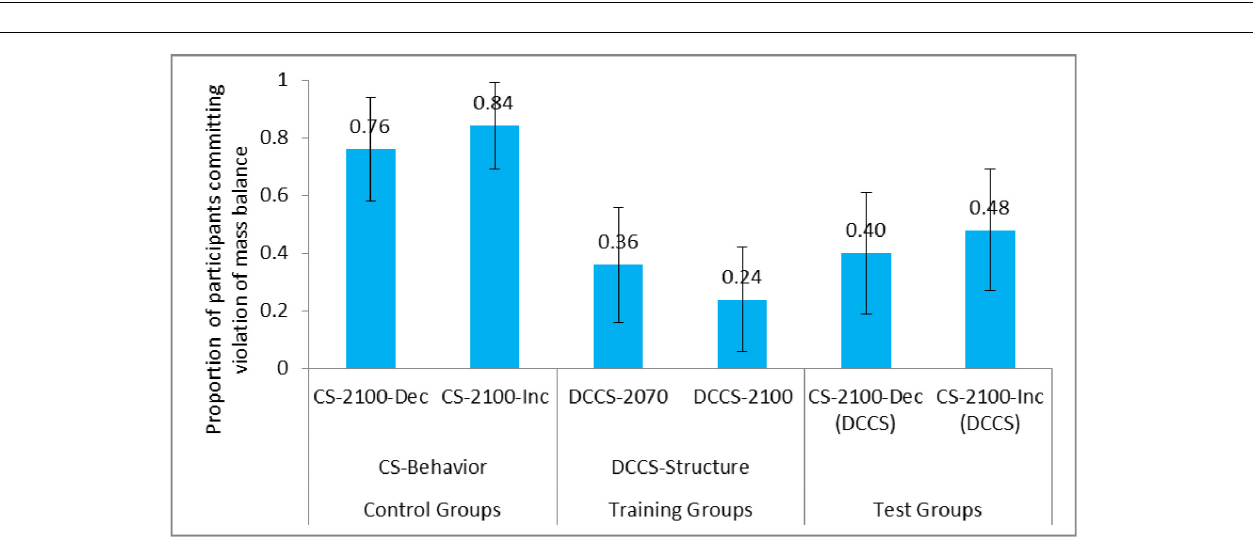
FIGURE 6 | Proportion of participants relying on correlation heuristic in surface conditions. The CS-Temp (DCCS) and CS-Climate (DCCS) refer to CS tasks following the DCCS performance in the DCCS-Surface condition. The error bars represent 95% confidence interval around the point estimate.